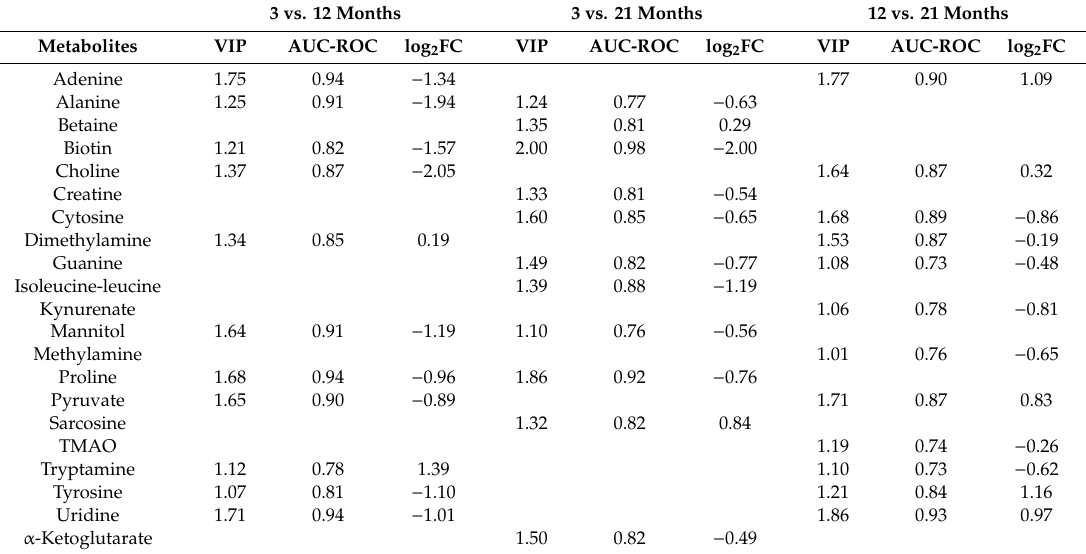
Table 1. Metabolites contributing to the discrimination between age groups. (Note: VIP: variable importance for the projection plot; AUC-ROC: area under the curve-receiver operating characteristic; log 2 FC: log 2 fold change. All results presented had p values < 0.001.)